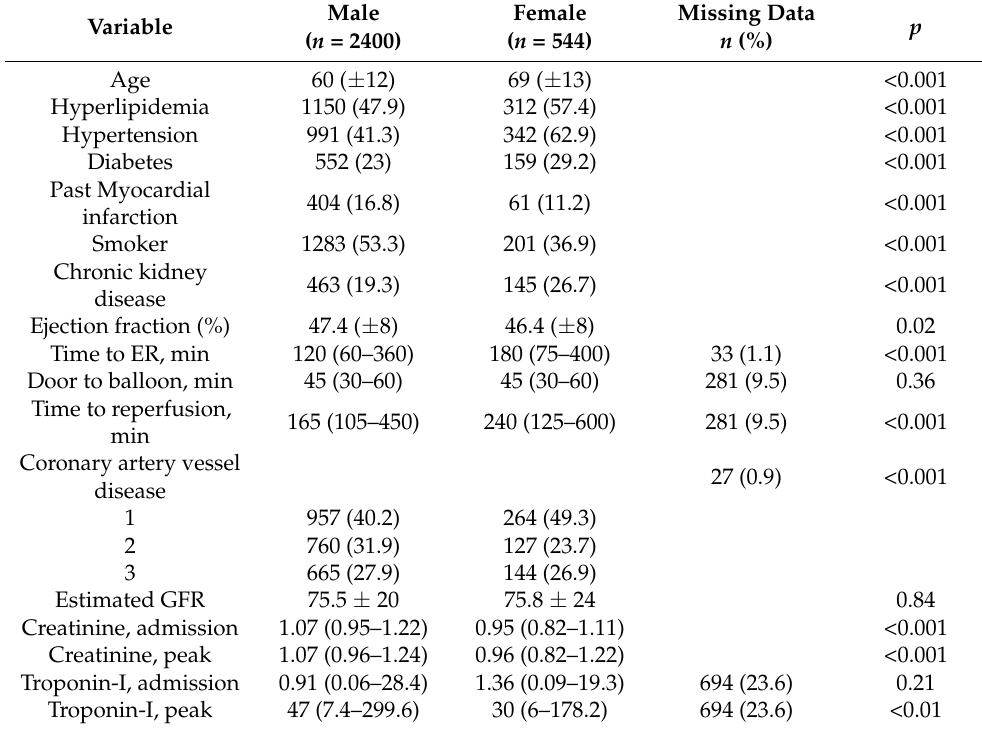
Table 1. Cohort demographic and clinical characteristics, compared by gender a